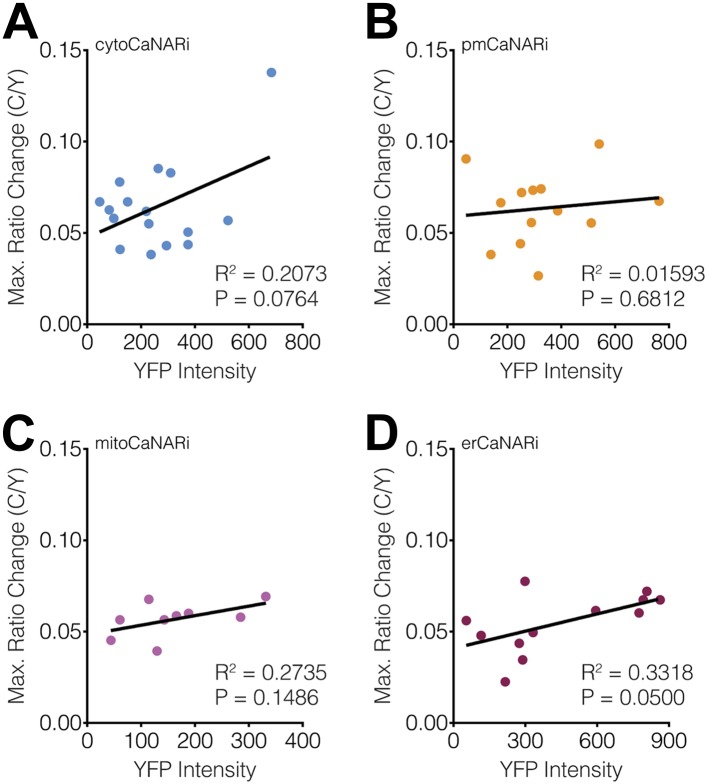
Subcellular CaNARi responses are not affected by the reporter expression level.Scatter plots showing the maximum C/Y FRET ratio change vs YFP intensity (i.e., reporter expression level) for (A) cytoCaNARi, (B) pmCaNARi, (C) mitoCaNARi, and (D) erCaNARi. Weakly positive correlations were detected using linear regression analyses, though none were statistically significant.